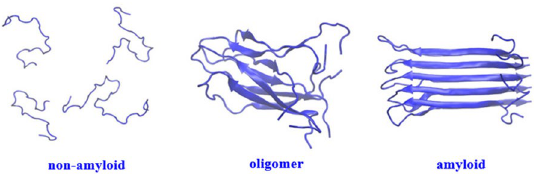
Figure 2. Schemes of peptide classes, representing a general idea.